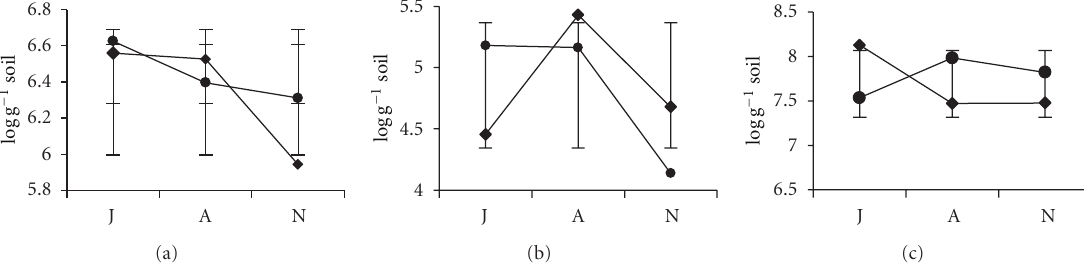
Figure 7: (a) Actinomycete, (b) protozoa, and (c) heterotrophic counts on a logarithmic scale displaying di ff erent reactions to monoculture and rotation in 2009. Monoculture = M - (cid:2) -; rotation = R - • -. Vertical bars denote standard deviation.